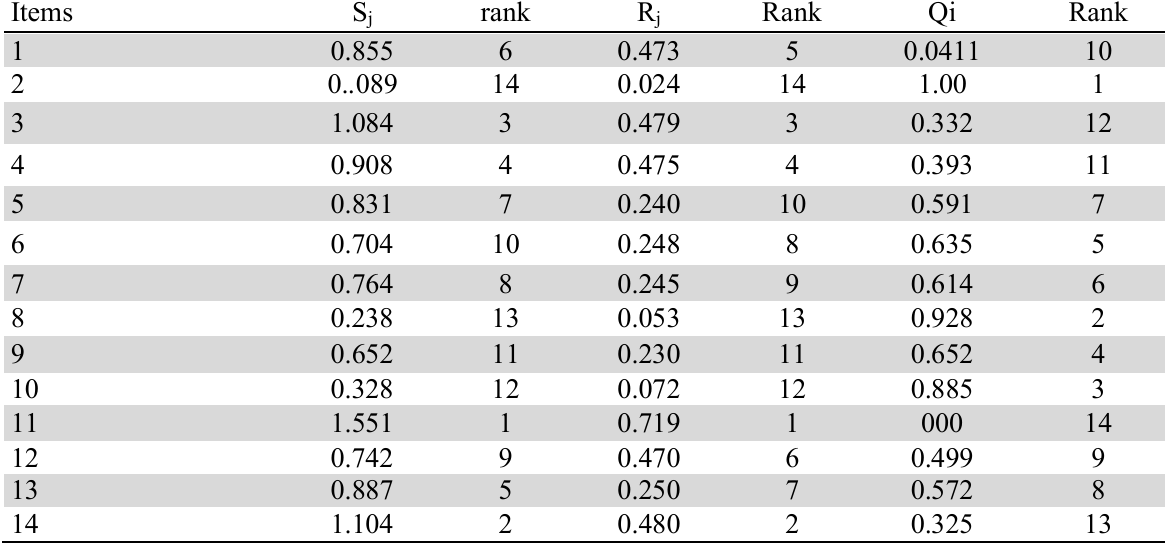
The summary of ranking of various factories